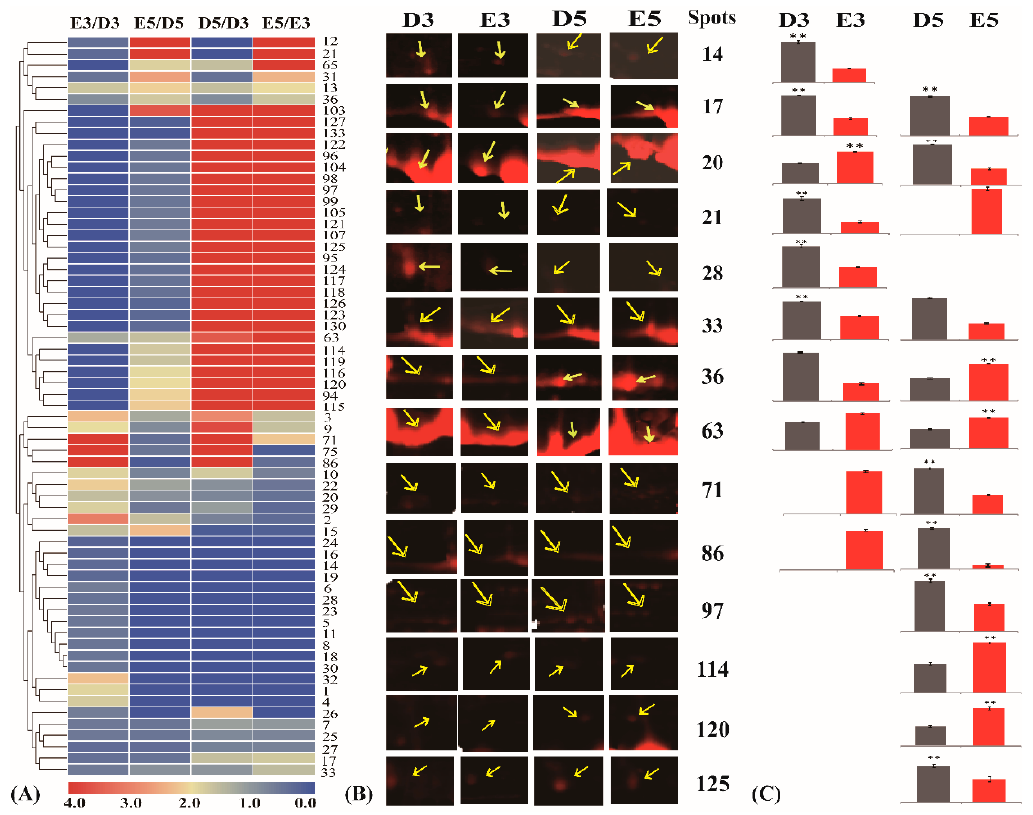
Figure 4. Changing patterns of differentially accumulated glycoproteins (DAGPs) after application of ethylene. The 65 glycosylated proteins with at least 1.5-fold changes were exposed to hierarchical clustering ( A ) to show their changed accumulation patterns after being treated with ethylene or water for three (E3/D3) or five (E5/D5) days. The changed ratios of these proteins after treating with water or ethylene for different times (D5/D3; E5/E3) are also presented. The up- or down-regulated proteins are indicated in red or green, respectively. The intensity of the colors increased with the increased accumulation, as shown in the bar at the bottom. The spot numbers are indicated in the heat plot, which includes five based areas from the top to bottom. The accumulation profiles ( B ) of 14 typical DAGPs in the 2-DE gels and their relatively changed ratios ( C ) are highlighted. The exact position of each protein spot was correspondingly presented in the four 2-DE gel areas.